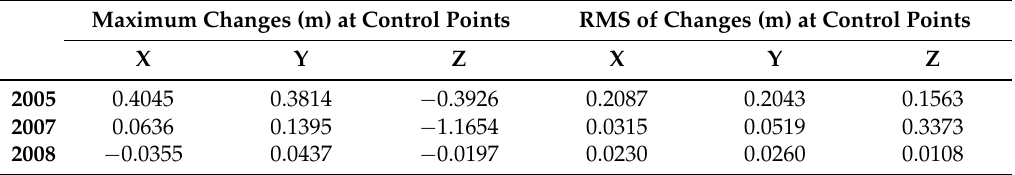
Table 1. The control point errors of three datasets after aerotriangulation